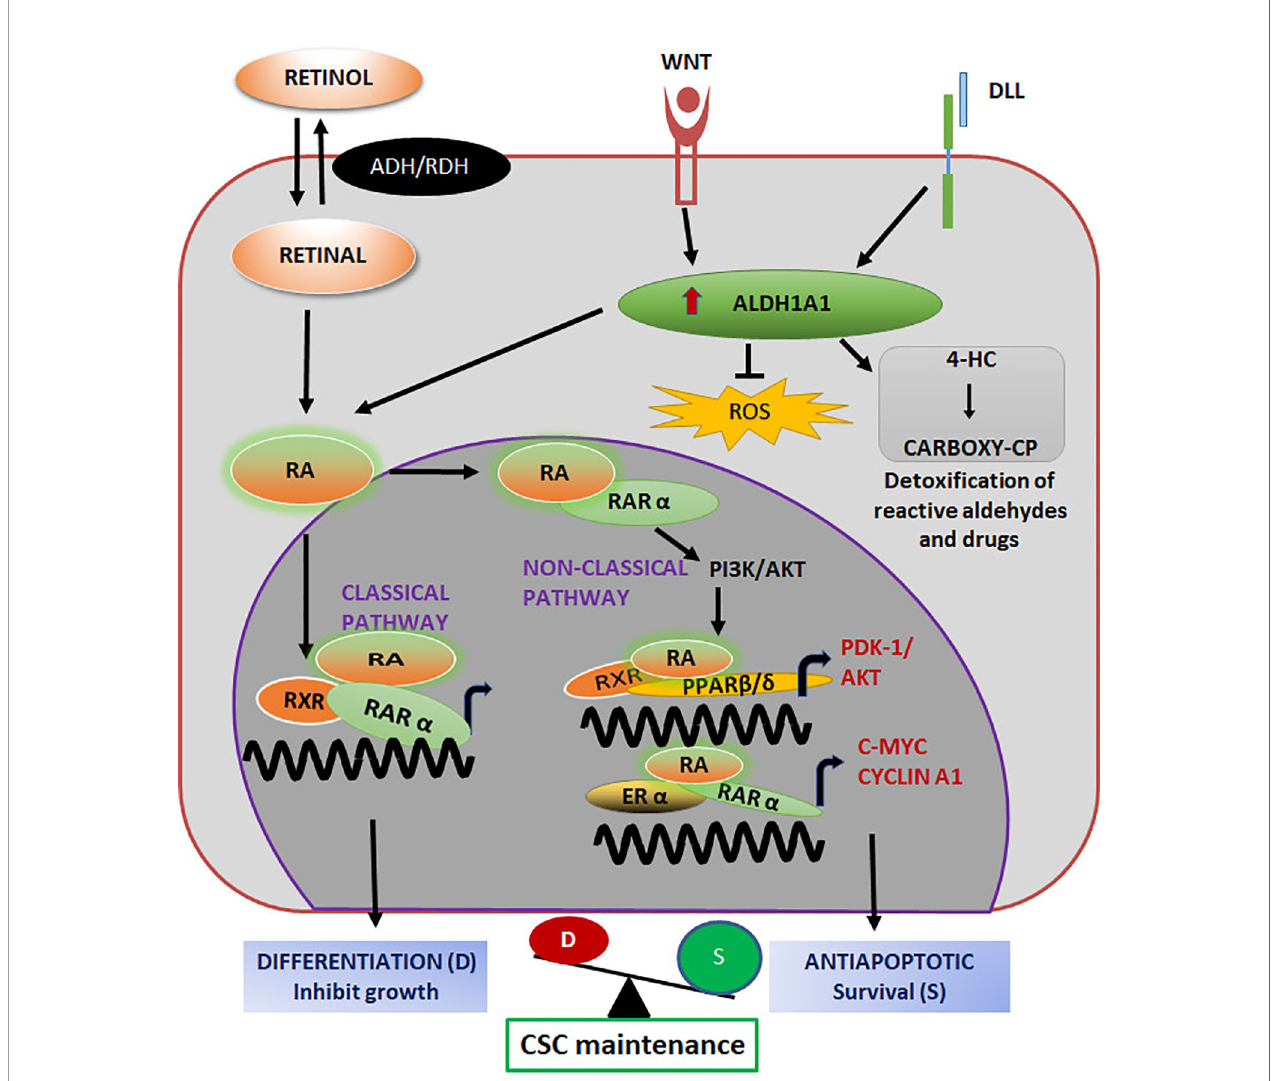
FIGURE 5 | ALDH1A1 in the regulation of CSC properties Both classical and non-classical pathways initiated by Retinol regulate stemness. Retinoic acid (RA) binds to its nuclear receptor RAR a and activates their target genes for differentiation. When RA binds to PPAR b / d /RXR or RAR a /ER a , genes related to survival and stemness are up-regulated. The balance of these pathways maintain CSC self-renewal and differentiation. The enzyme activity of ALDH1A1, results in the detoxi fi cation of chemotherapeutic drugs to impart